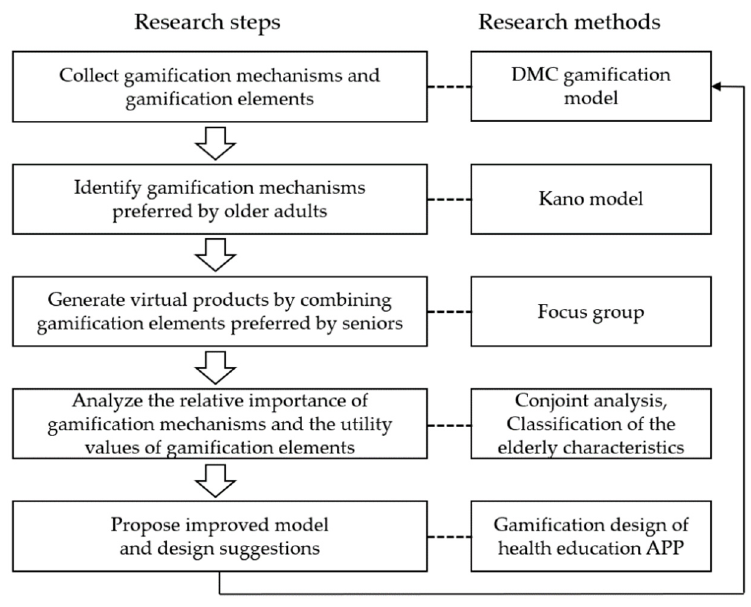
Figure 2. Research framework.